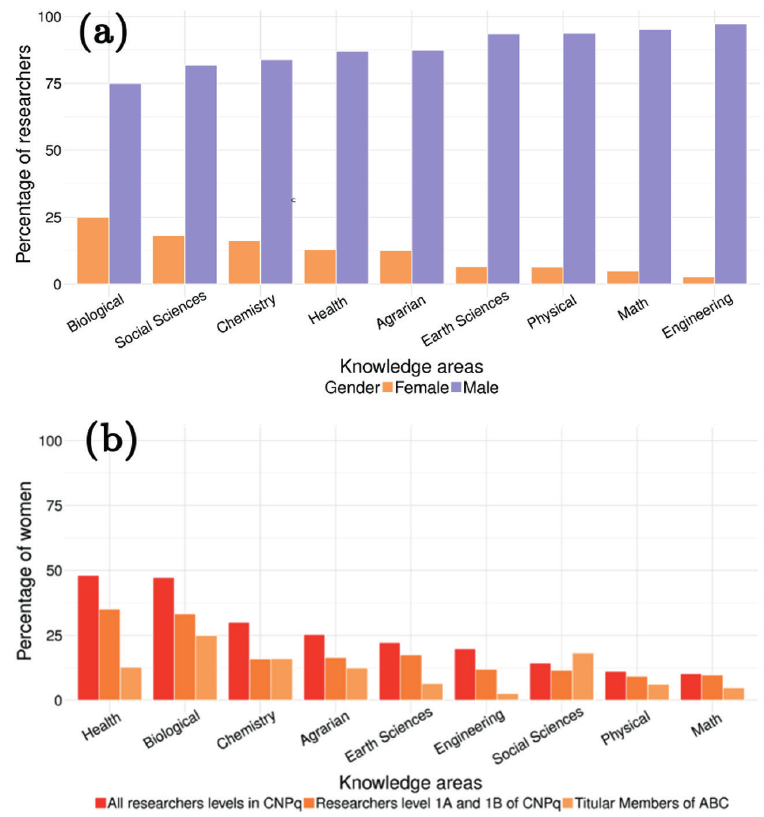
Figure 2 - a) Percentage of male and female members of the ABC in each area; b) percentage of female members of the ABC, of the CNPq PQ-research and of the CNPq 1A and 1B PQ-research members in different